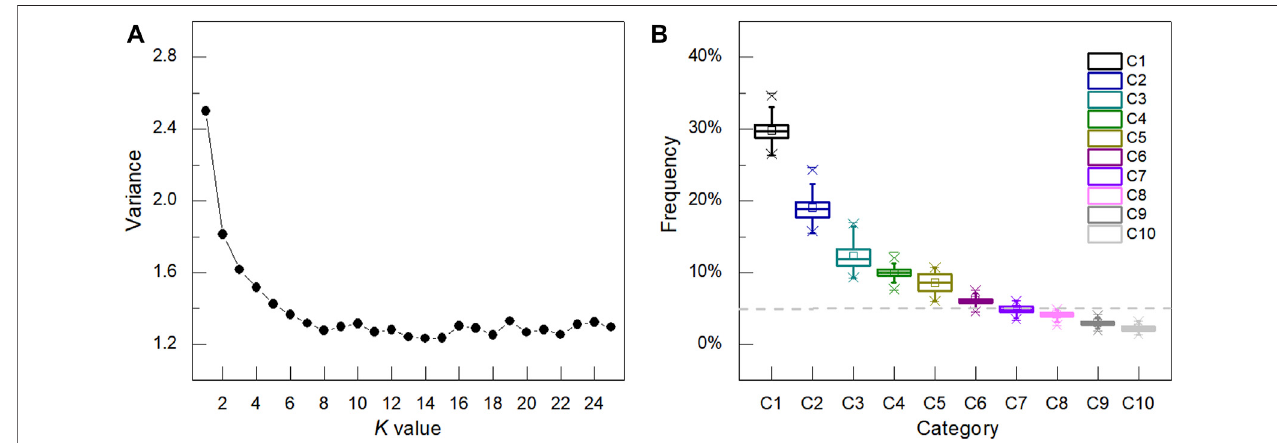
FIGURE 3 | (A) The average distance between the sample and the center corresponding to different k values. (B) Percentage box line chart of clustering samples ( k (cid:1)